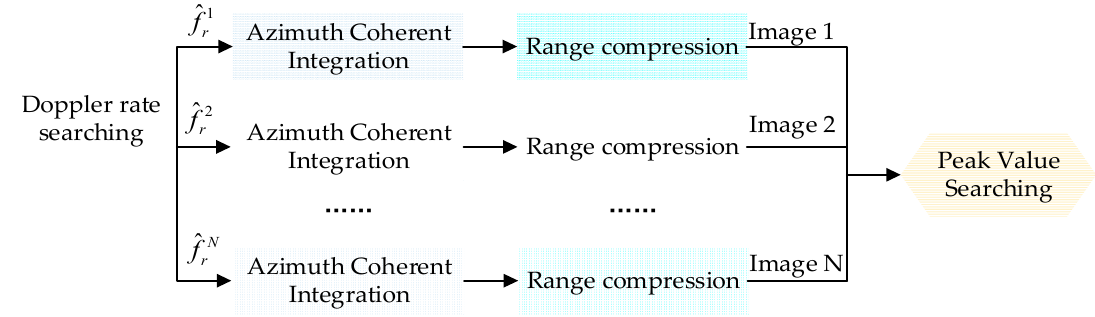
Figure 4. Processing steps of parallelized estimation of the Doppler rate.